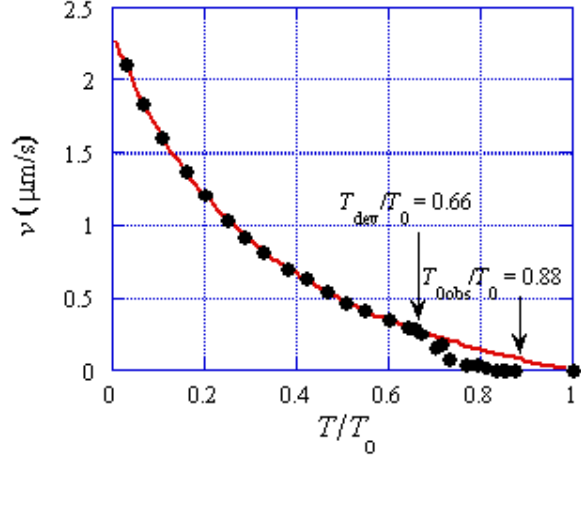
and T . The red curve is dev 0obs